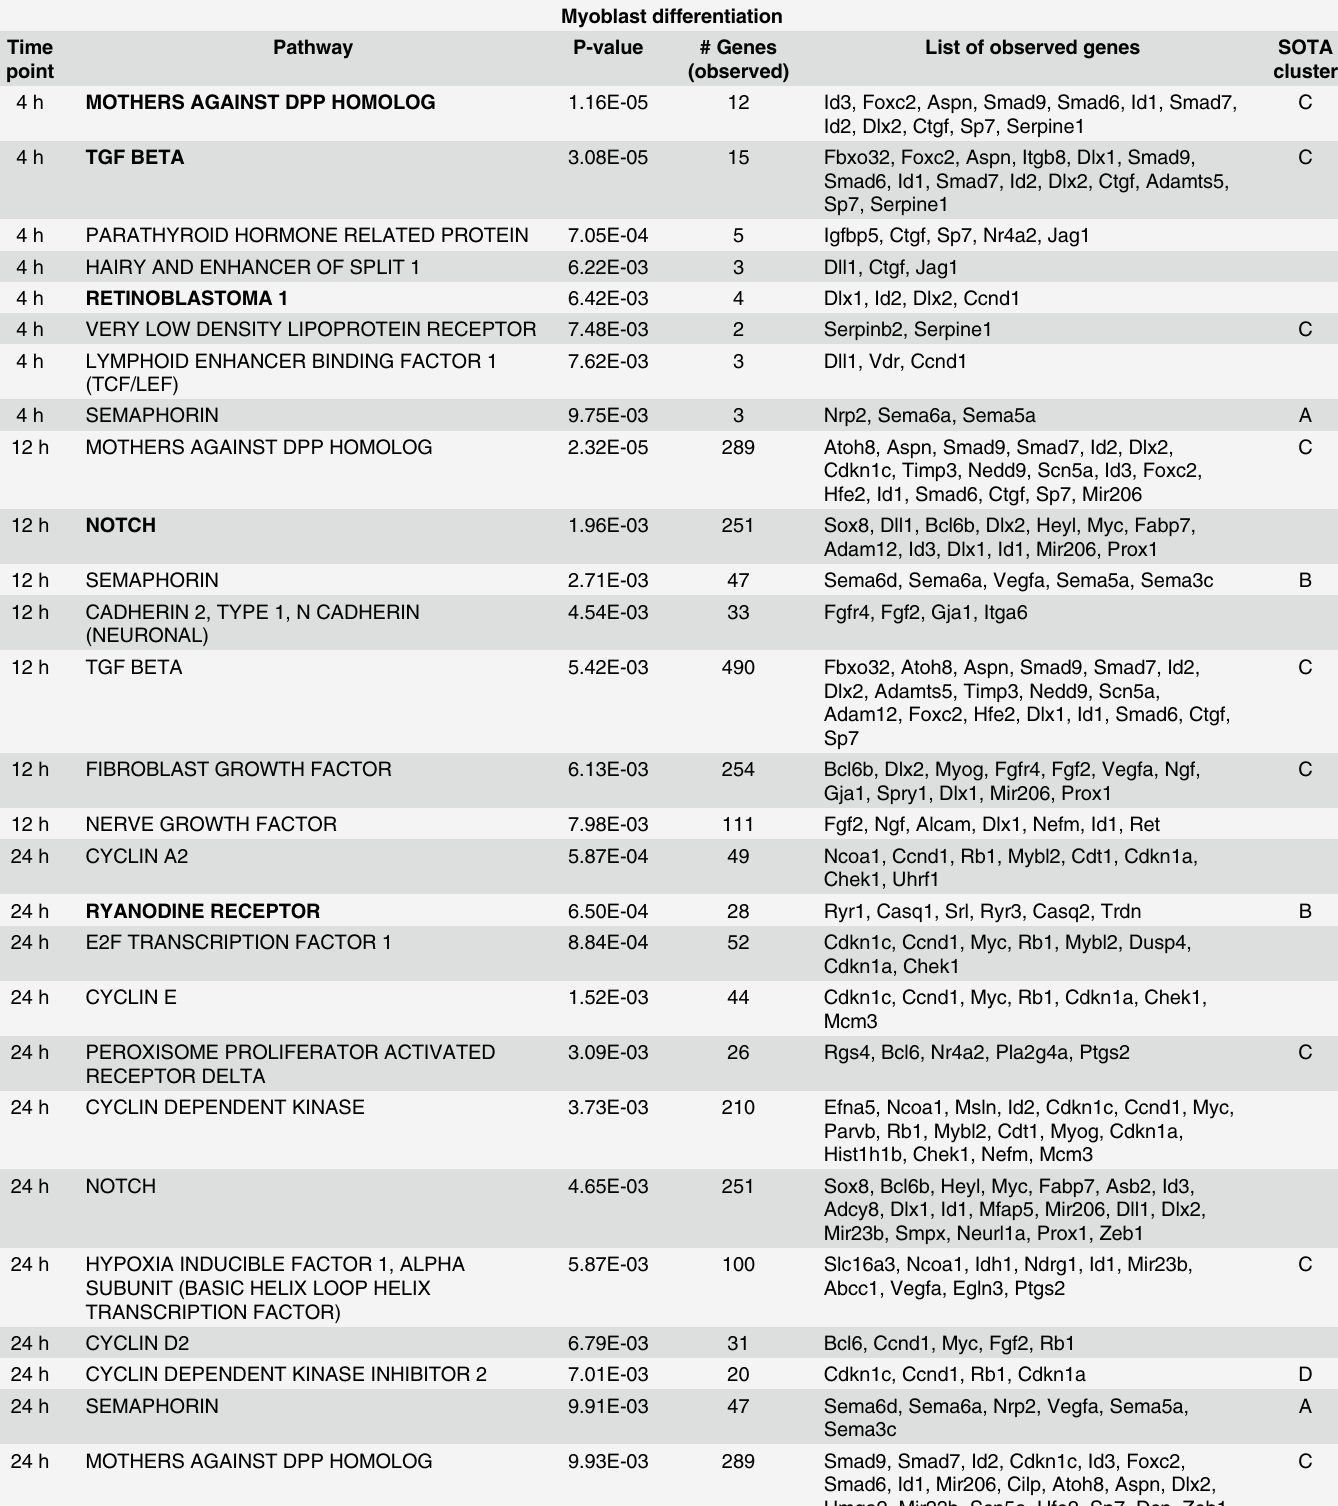
Table 3. Pathway enrichment analysis of differentially expressed